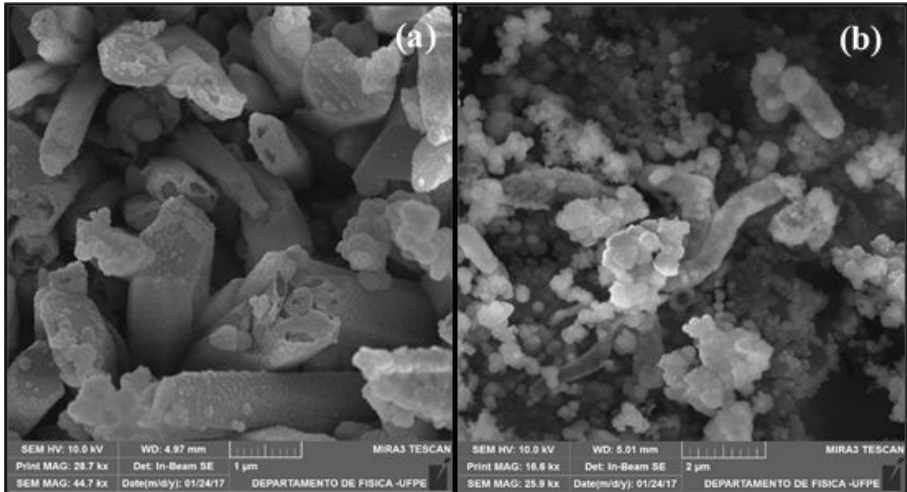
Figure 5. Micrographs of the film and biofilm formed on the coupon surface after 15 days of exposure to (a) abiotic and (b) biotic systems. Magnification of 44.700x (a) and 25.900x